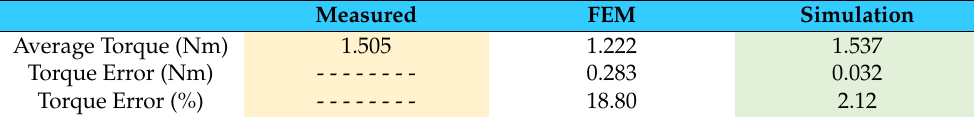
Table 3. Summary of torque results.